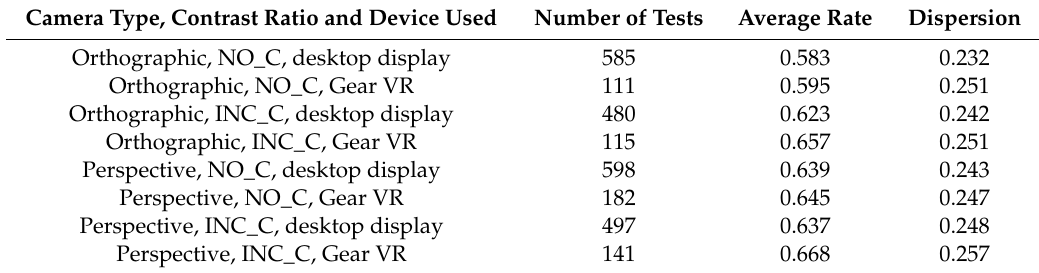
Table A17. Numerical results of the users regarding the camera type, contrast ratio and device used. Camera Type, Contrast Ratio and Device Used